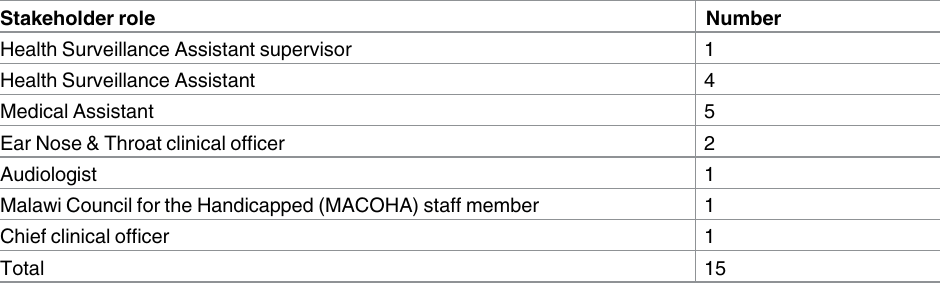
Table 3. Key stakeholders